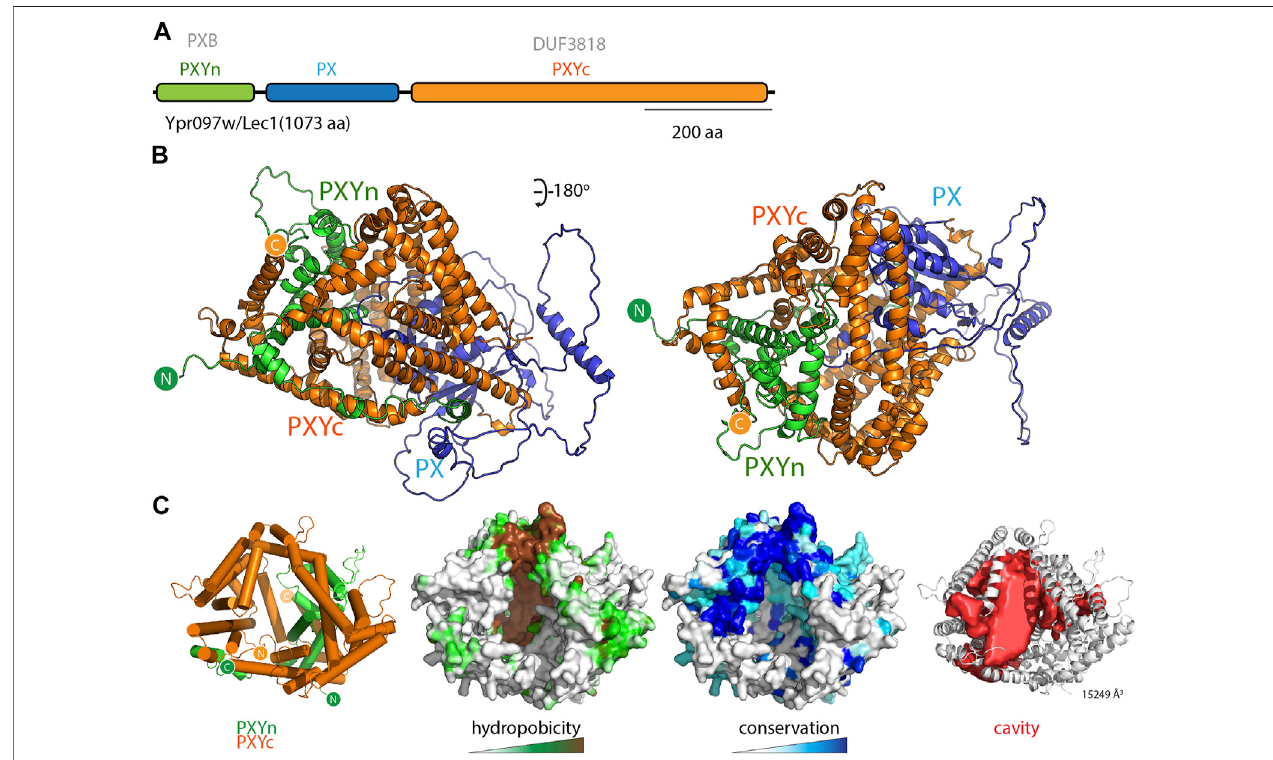
FIGURE6 | The yeast Lec1/Ypr097w protein forms aunique structure with ahydrophobiccavity. (A) Domain structure ofthe S. cerevisiae Lec1/Ypr097w protein. (B) AlphaFold2structuralpredictionoftheLec1/Ypr097wproteinwiththePXYndomainingreen,PXdomaininblueandPXYcdomaininorange. (C) ThePXYnandPXYc domainsare shown with α -helicesin cylinder representation and thePX domain removedfor clarity.Thedomains encompassalarge conserved hydrophobic cavityand liketheSNX-RGSproteinsmaybeapotentiallipidbindingprotein.Thefarrightpanelshowsthesolventaccessiblecavity(redsurfacerepresentation)identi fi edwith POCASA (Yuet al., 2010) and the volume (Å 3 ) ofthe largest identi fi ed cavityis indicated (Roderick et al., 2002; Samygina et al., 2011; Schauder et al., 2014; Dong et al., 2019).